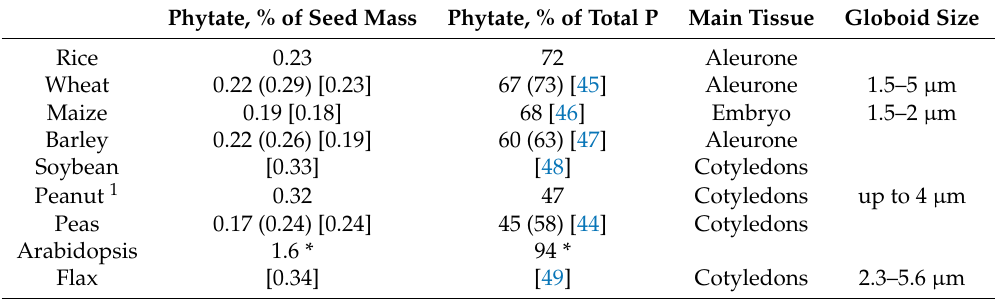
Table 1. Phytate content and the proportion of the total phosphorous of selected seeds according to Eeckhout and De Paepe (1994) [42], Viveros et al. (2000) (values in ()) [43], Steiner et al. (2007) (values in []) [44] and Nagy et al. (2009) (marked with *) [14]. The main storage tissue and size of the globoids is given as discussed in Sections 3.1–3.5. Phytate, % of Seed Mass Phytate, % of Total P Main Tissue